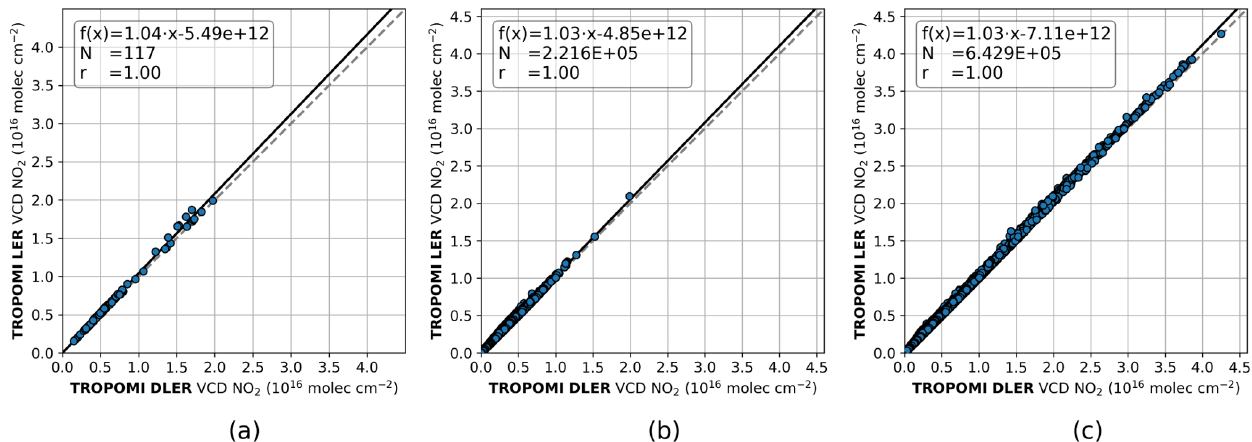
Figure A10. Scatter plots of TROPOMI IUP V02.03.01 tropospheric NO 2 VCDs with TROPOMI LER and TROPOMI DLER for (a) the 117 TROPOMI pixels coinciding with the AirMAP measurements used throughout the study, (b) a larger orbit segment over western Europe on 13 September 2020, and (c) one full orbit including the campaign area on 13 September 2020. All data are quality and cloud filtered using the qa_value of